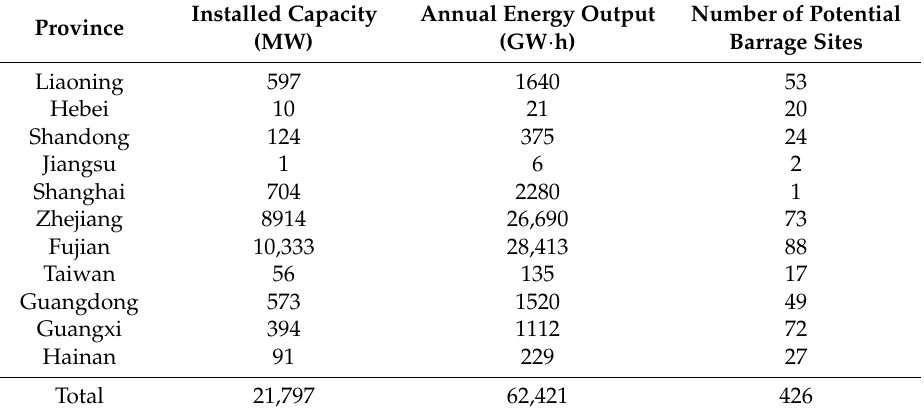
Table 1. Tidal energy resources and number of potential barrage sites in the coastal provinces of